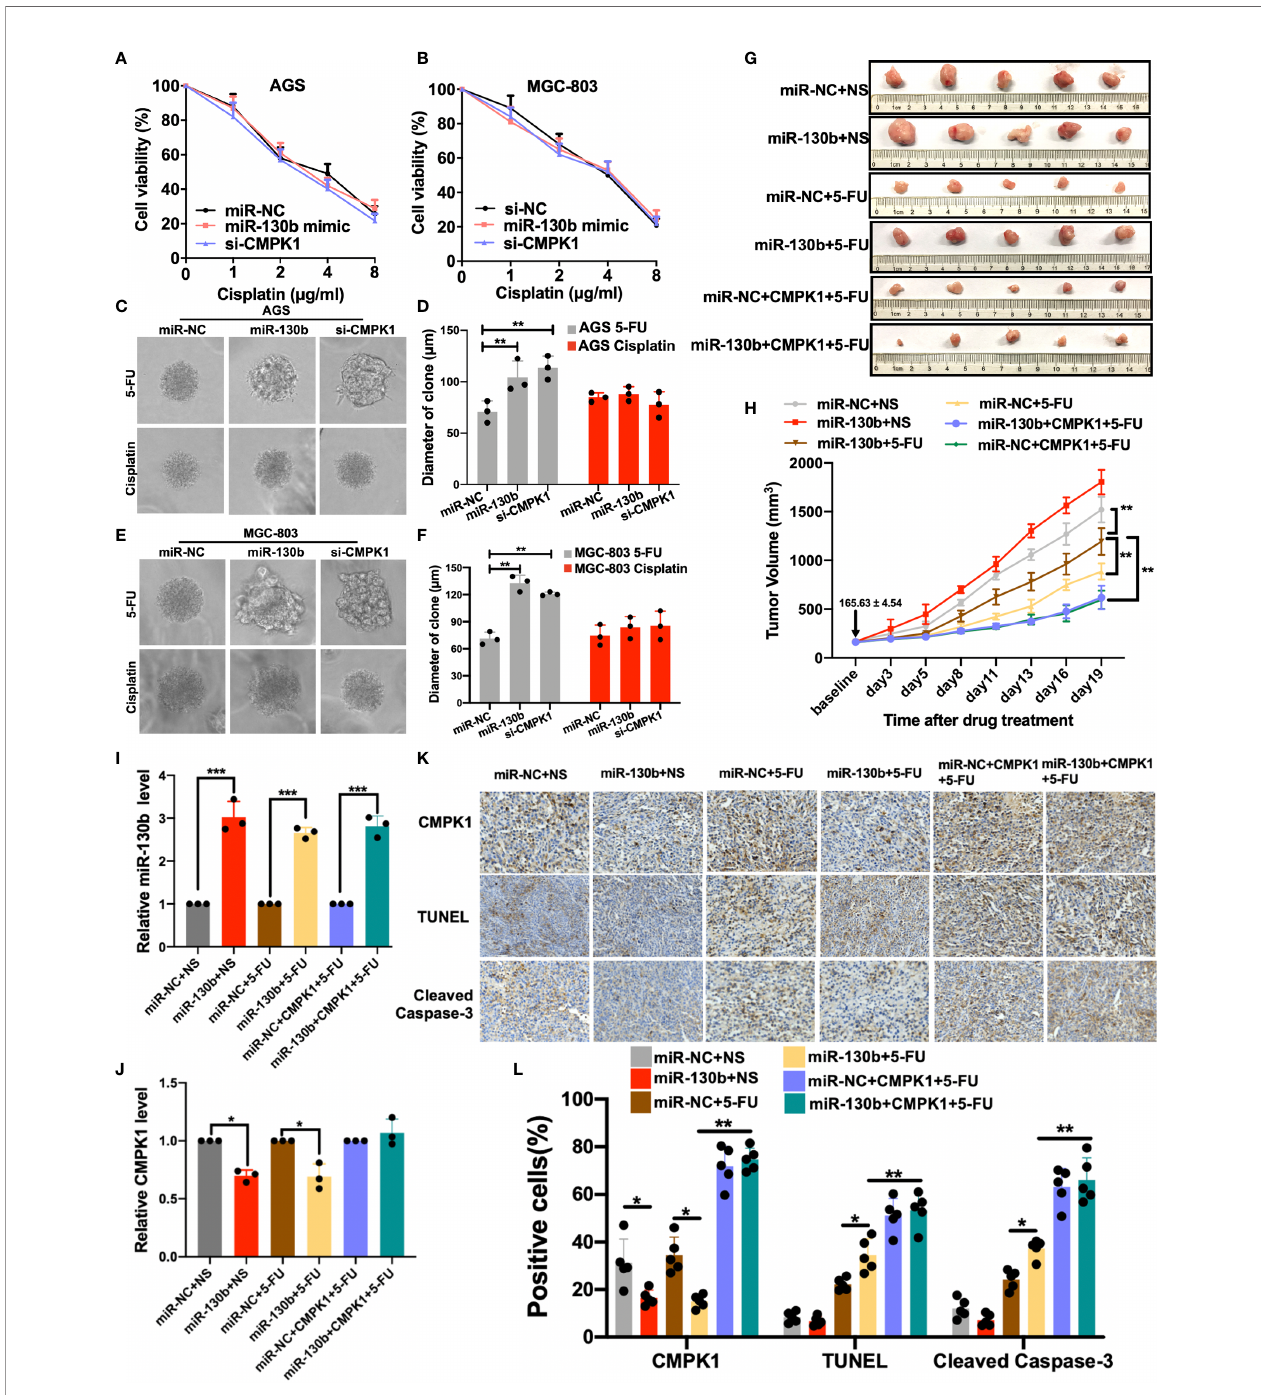
FIGURE 5 | MiR-130b-mediated regulation of CMPK1 in fl uences chemoresistance to 5-FU (A, B) AGS and MGC-803 cells were transfected with miR-NC, miR- 130b mimic or si-CMPK1. After 48 h, cells were reseeded for cisplatin sensitivity detection by MTT assay. (C, D) The 3-D culture assay showed that 5-FU treatment, but not cisplatin, signi fi cantly impacted miR-130b/miR-NC/si-CMPK1 cell growth on martrigel matrix. AGS cell spheroids, morphological changes, and the diameter of clone is shown in (C, D) , MGC-803 cell spheroids are shown in (E, F) . (G) Representative images of orthotopic gastric cancer mouse model for 5-FU sensitivity in miR-NC, miR-130b, and CMPK1-treatment. The scale was millimeters. (H) Mean tumor volumes in mice treated with different combination of miR-NC, miR-130b, CMPK1 and 5-FU regimens. Expression level of miR-130b (I) and CMPK1 (J) in different xenograft mouse model by q-PCR analysis. (K) Tumor samples from control- and miR-130b-treated mice were sectioned and stained for CMPK1, TUNEL and Cleaved Caspase-3 by immunohistochemistry (IHC). (L) Quanti fi cation of CMPK1, TUNEL and Cleaved Caspase-3 positive cell level. Error bars, ± SD. (*P < 0.05, **P < 0.01, ***P <